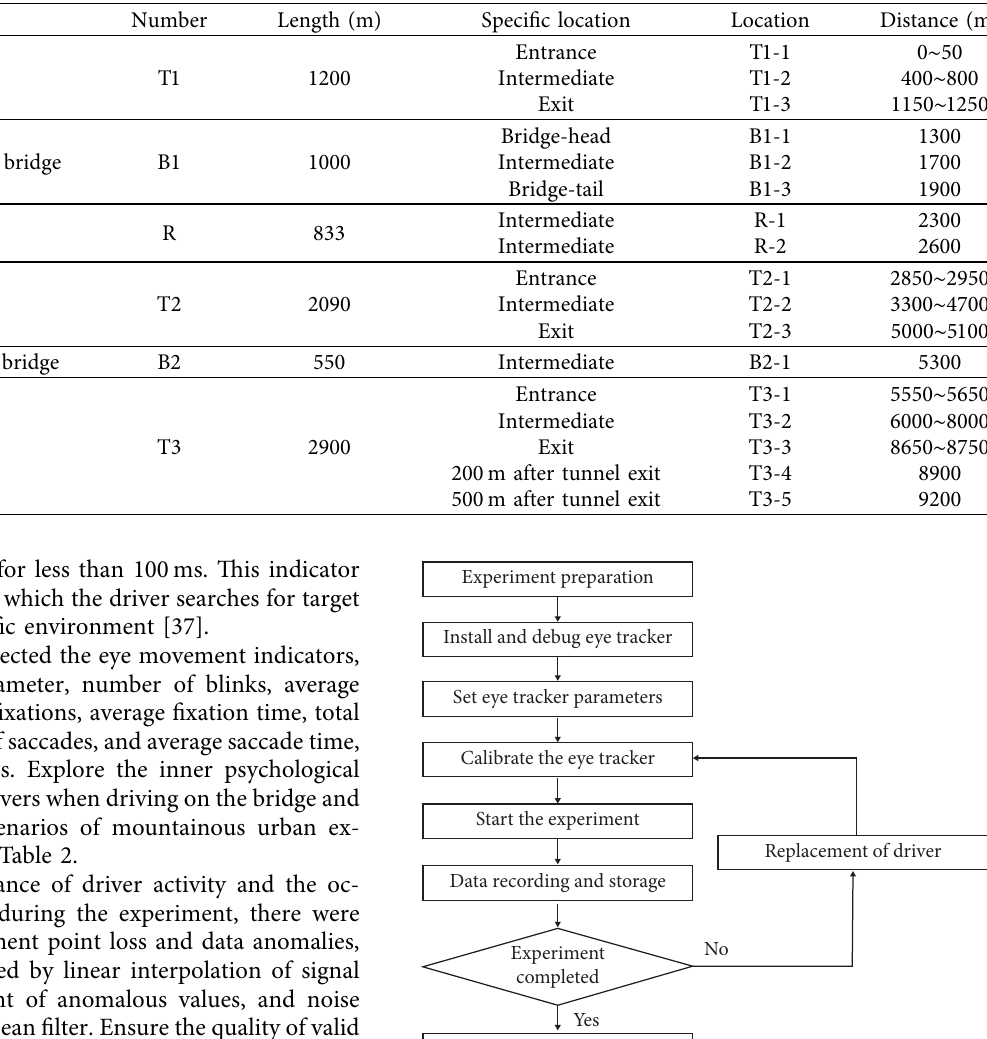
Table 1: Experiment-road